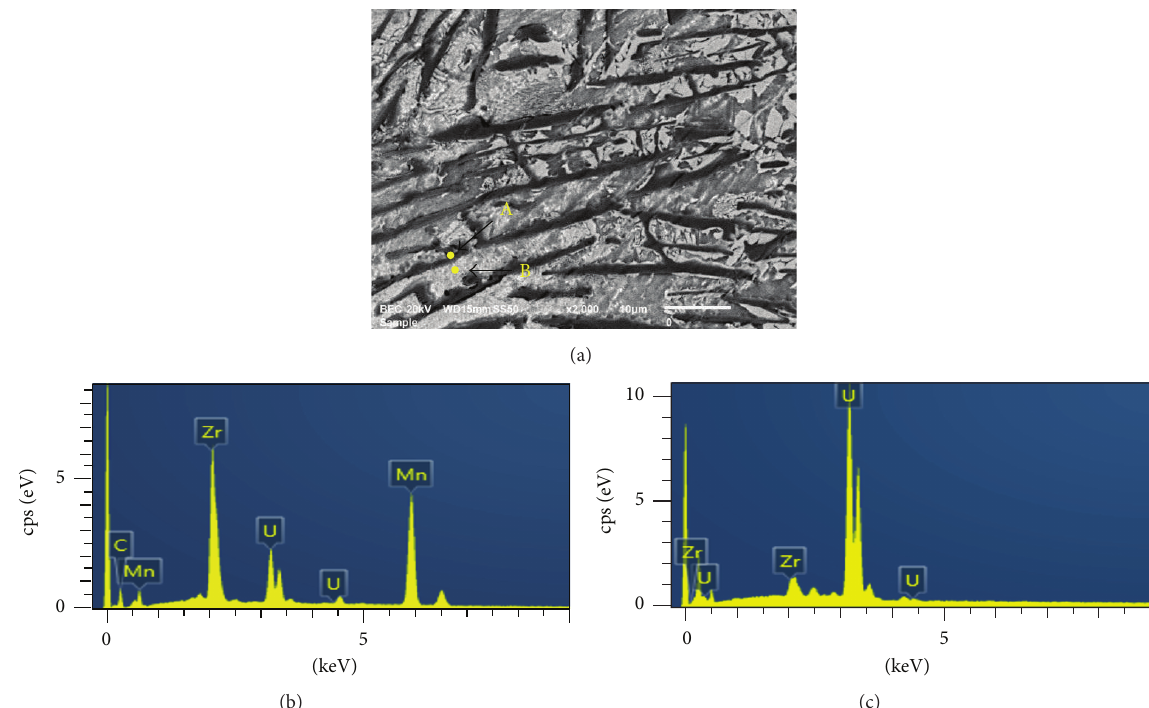
Figure 8: (a) Magnified image of the micrograph shown in Figure 7(a), and EDX spectra at (b) spot “A” and (c) spot “B” marked in (a).